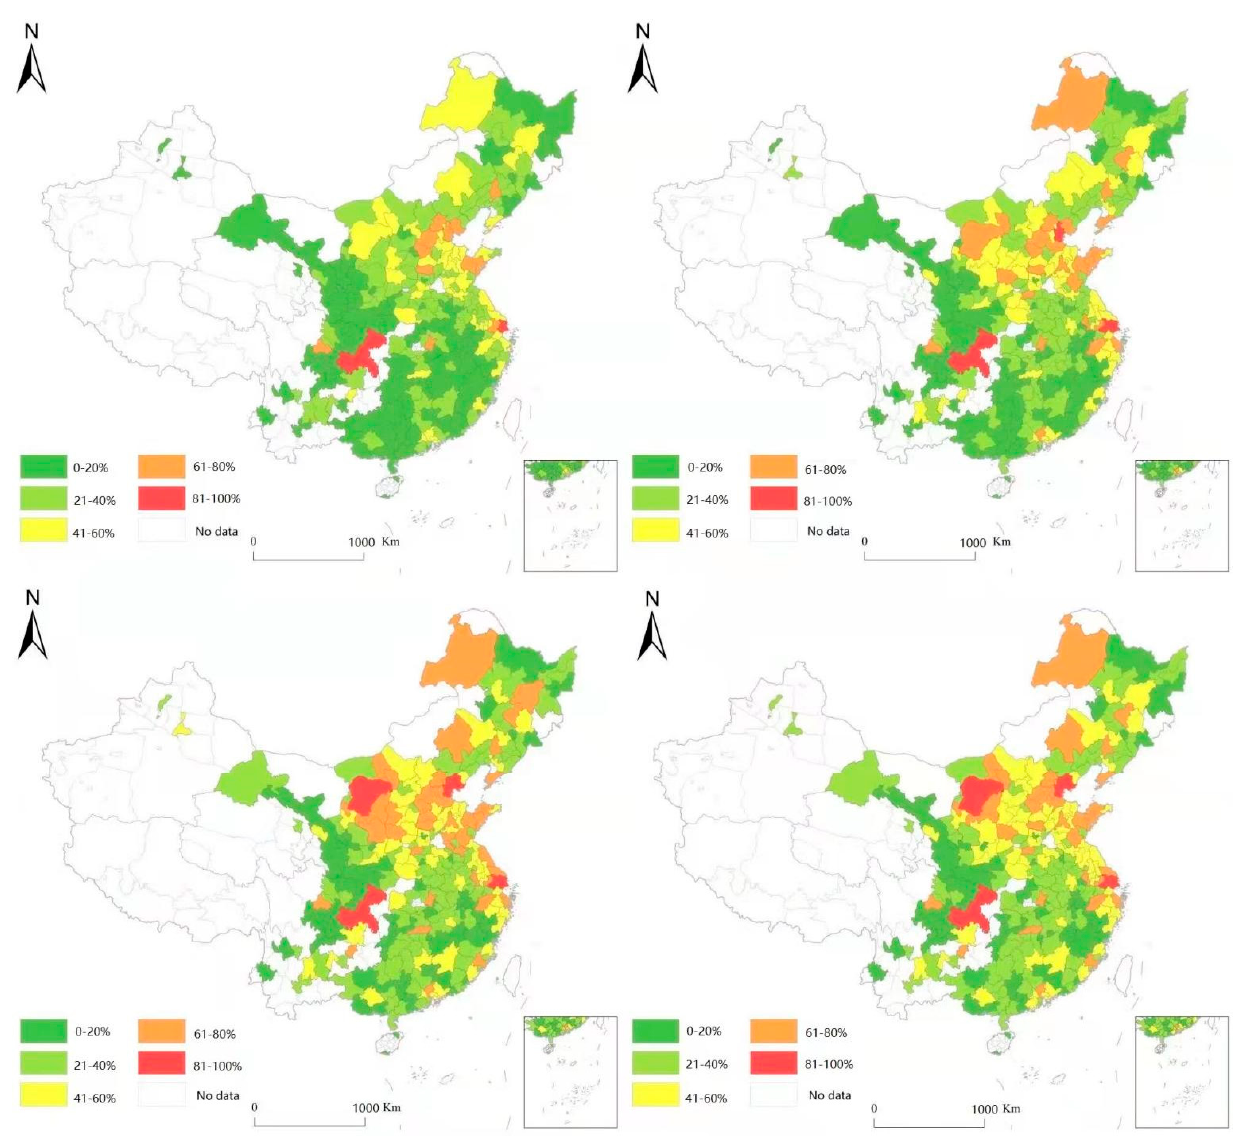
Figure 1. China’s urban carbon footprint in 2009, 2013, 2016, and 2019.